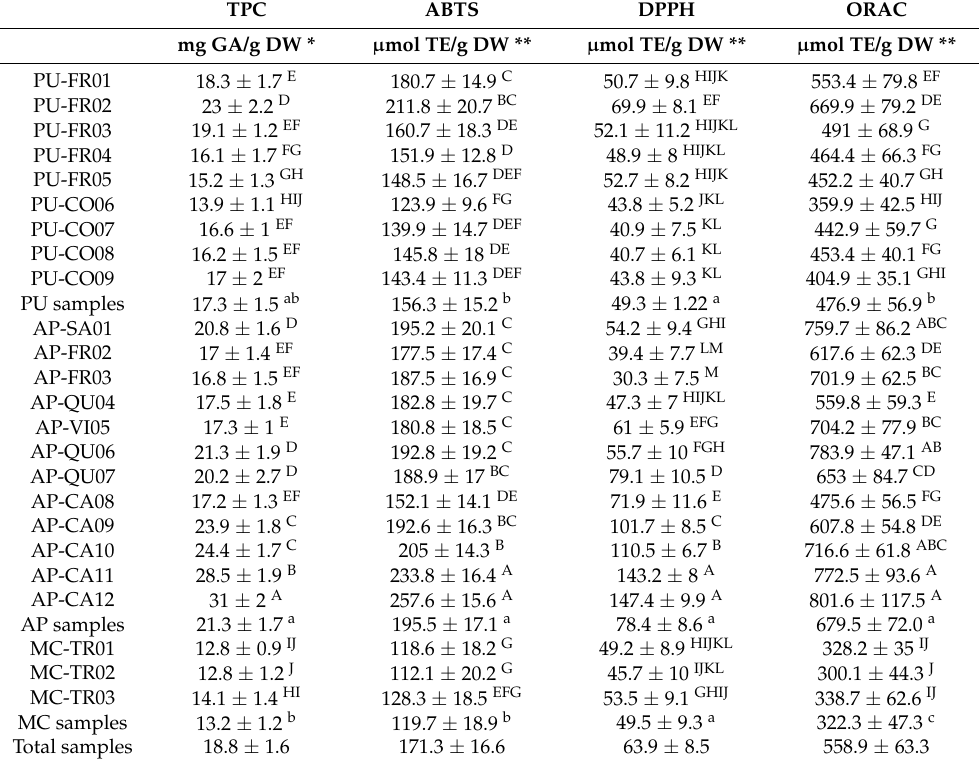
Table 2. Total phenolic content (TPC) and antioxidant activity data of studied bee pollen samples. Samples are grouped and also mediated by province. Superscript letters within each column indicate homogeneous subclasses resulting from Tukey’s post hoc multiple comparison test ( p < 0.05) per- formed between all samples (uppercase) or between means of data of the same province